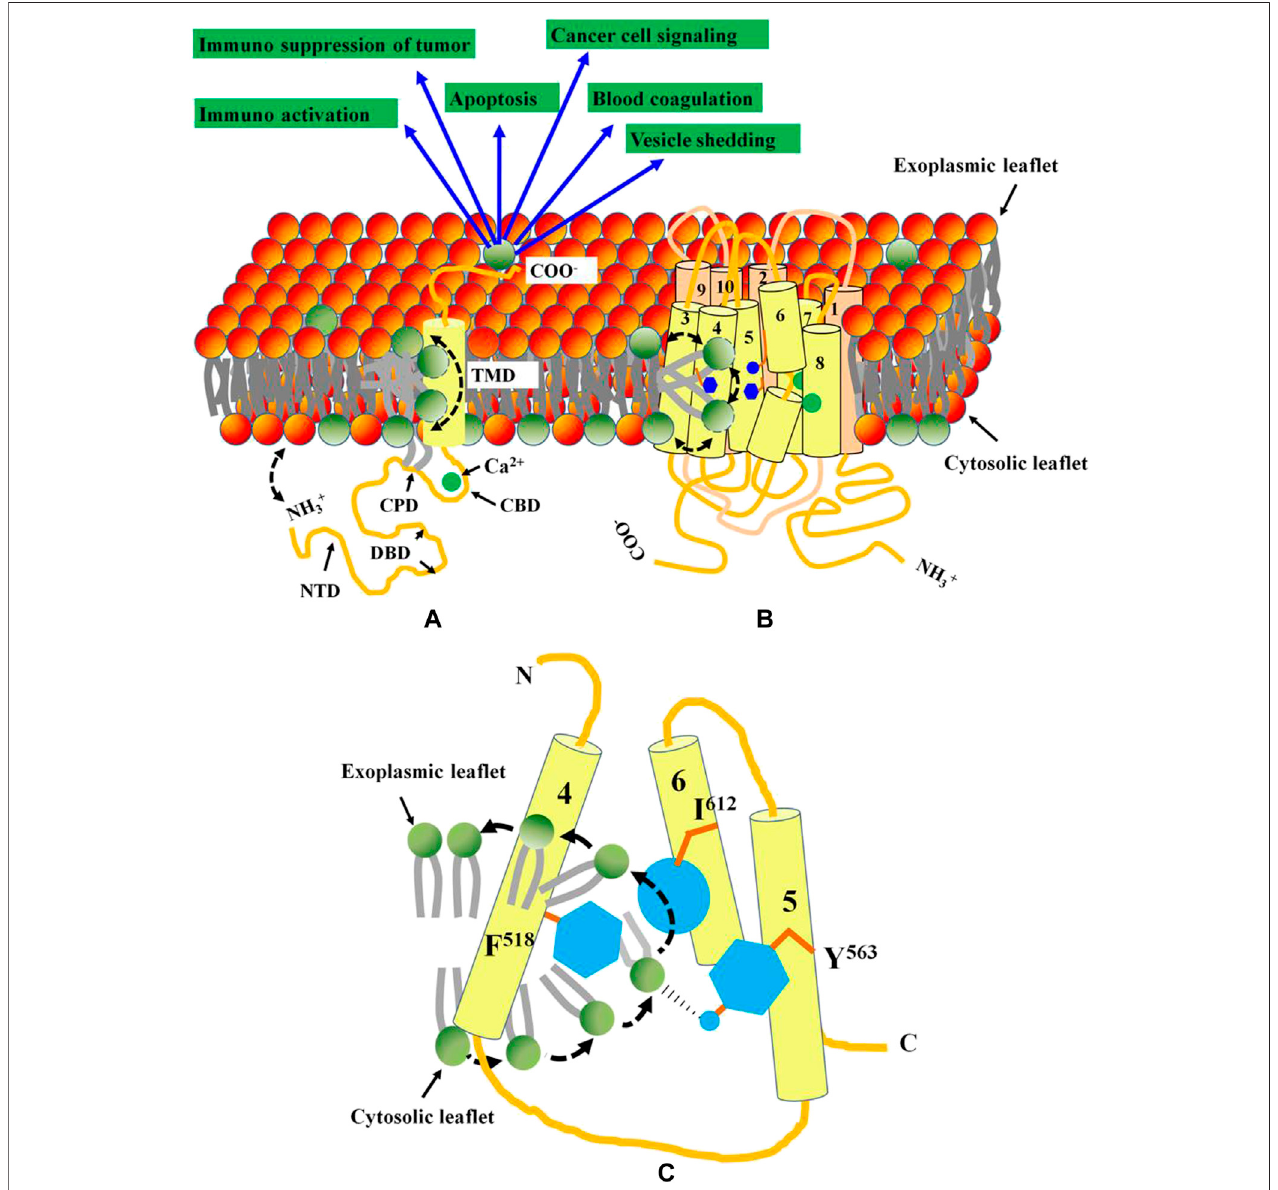
FIGURE 1 | Functional domains and topology of PLSCR1 and TMEM16F. (A) PLSCR1 is a type II membrane protein with a short exoplasmic C-terminal tail, a transmembrane domain, a Ca2+-binding EF-hand like domain, a nuclear localization signal, a cysteine palmitoylation domain and a cytosolic N-terminal domain. Ca2+ binding to the EF-hand like domain, plausibly leads to conformational changes in the N-terminal domain essential for PL scrambling. The bilayer defect created by the close proximity ofNTD towards plasma membrane results in transbilayer scrambling oflipids. (B) The TMEM16F has 10 transmembranedomains with both Nand C-termini localized to cytosol. The Ca 2+ -binding domains are localized at the interface between TMDs 6, 7 and 8. A hydrophilic groove created by TMDs 4, 5 and 6 facilitates PL scrambling. (C) The PL scrambling pathway is gated by three residues (shown in blue) F 518 , Y 563 and I 613 on TMDs 4, 5 and 6 respectively. While the non- polar side chains of F 518 and I 613 facilitate the stabilization of the acyl chains of PL, the – OH in polar Y 563 facilitates the fl ipping of the head group. Activation of both PLSCR1 and TMEM16F leads to PS exposure on cell surface that activates multiple cellular events.